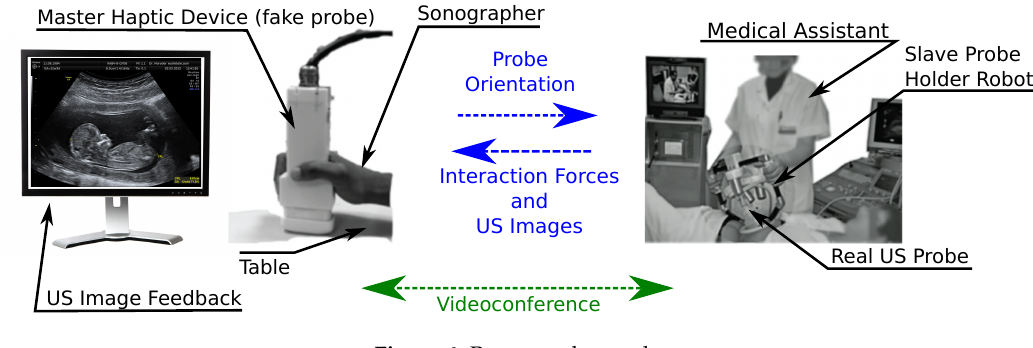
Figure 6. Remote echography.